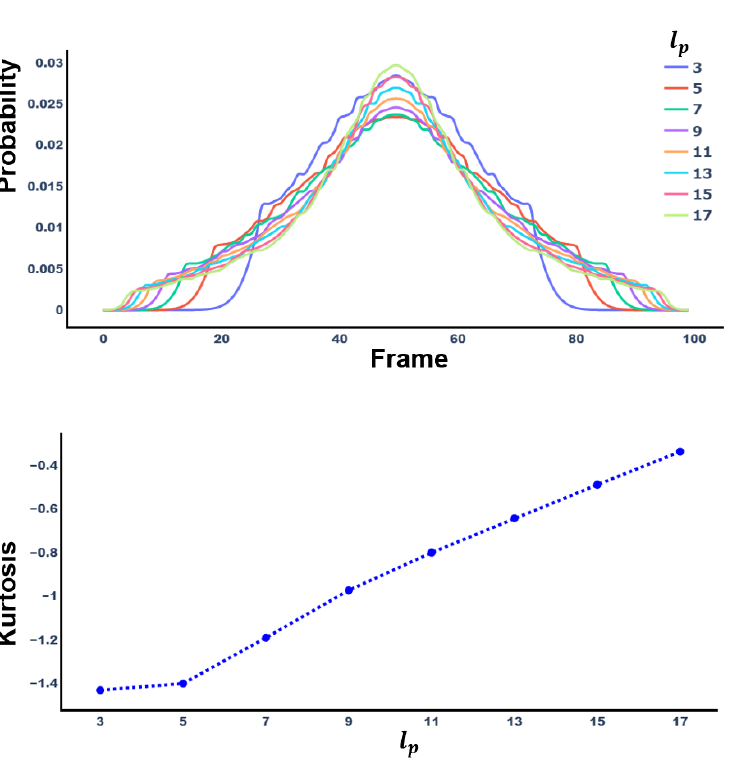
Figure 5. Change of probability distribution and kurtosis following n . ( Top ) Probability distribution of probability set, F ∗ n , according to the change in l p . ( Bottom ) Kurtosis of F ∗ n according to the change in l p